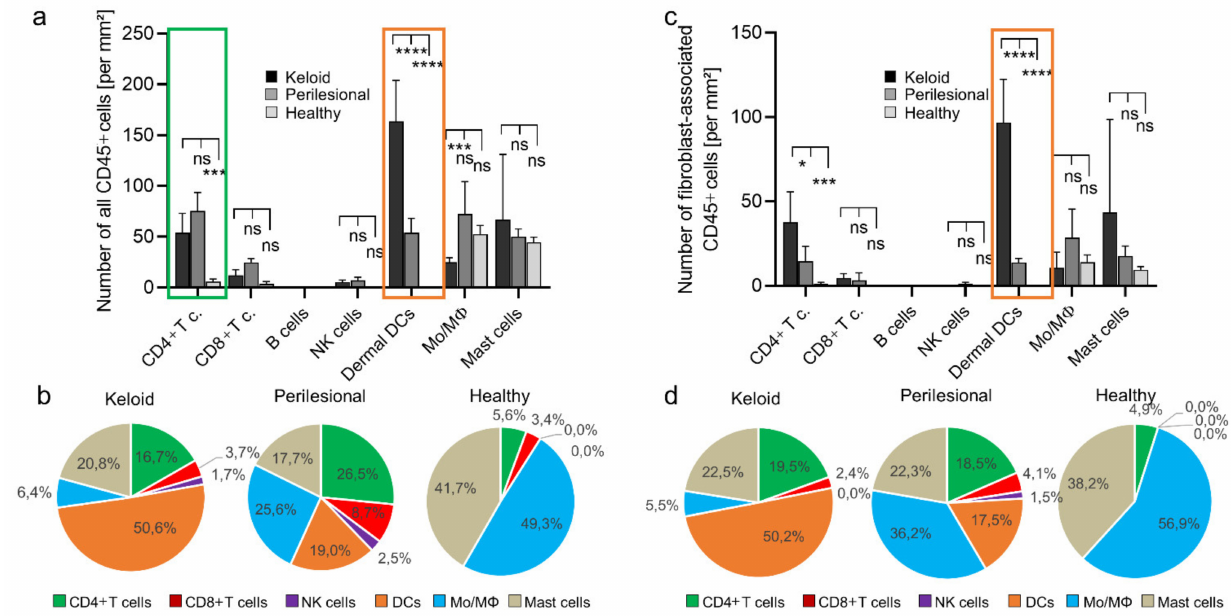
Figure 2. A high abundance of dermal dendritic cells in keloid. ( a ) The entire population of CD45+ cells was subclassified and subsequently quantified for keloid, perilesional and control tissue. Immune subsets were characterized by following marker combination: CD4+ T cells (CD3+, CD4+), CD8+ T cells (CD3+, CD8+), B cells (CD20+), NK cells (CD3-, CD56+), dermal DCs (CD1a+, CD11c+), monocytes/macrophages (Mo/M Φ ) (CD14+, CD68+), mast cells (CD117+). ( b ) Pie charts showing the relative abundance distribution of immune subsets in keloid, perilesional and control tissue, classified in ( a ). Each pie slice represents a distinct immune subtype. ( c ) The fibroblast-associated CD45+ cell population determined in Figure 1 was divided in different leukocyte subtypes (see Figure 2a) and quantified for keloid, perilesional and control tissue. ( d ) Pie charts of the relative distribution of immune cells classified in ( c ). Each pie slice represents a certain immune subtype. Data are means ± SEM from n patients ( n (Keloid) = 8, n (perilesional) = 8, n (control) = 5). Statistical significance was assessed based on the p value (ns p > 0.5,* p < 0.05, *** p < 0.001, **** p < 0.0001) and determined using two-way ANOVA and Tukey’s